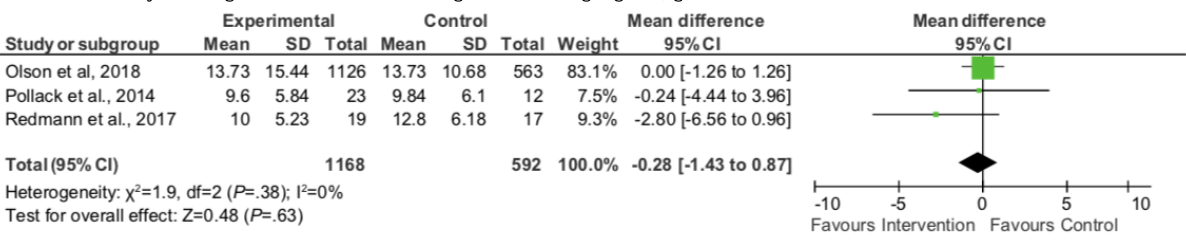
Figure 2. Pooled analysis of digital interventions on total gestational weight gain (kg)—intention-to-treat studies.